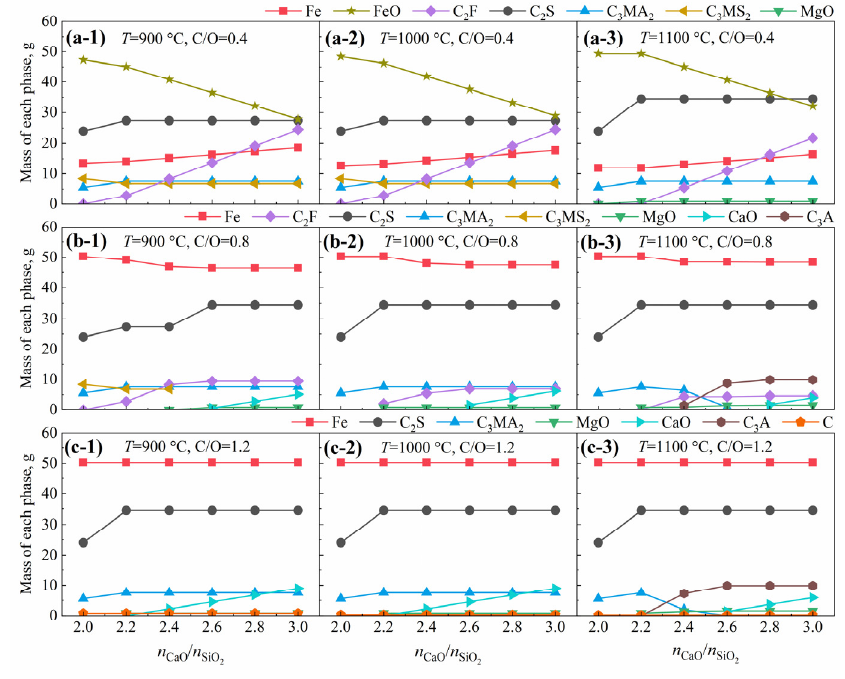
Figure 11. The effect of various gangue compositions on iron reduction: ( a ) C/O = 0.4; ( b ) C/O = 0.8; ( c ) C/O = 1.2; ( 1 ) T = 900 °C; ( 2 ) T = 1000 °C; ( 3 ) T = 1100 °C.